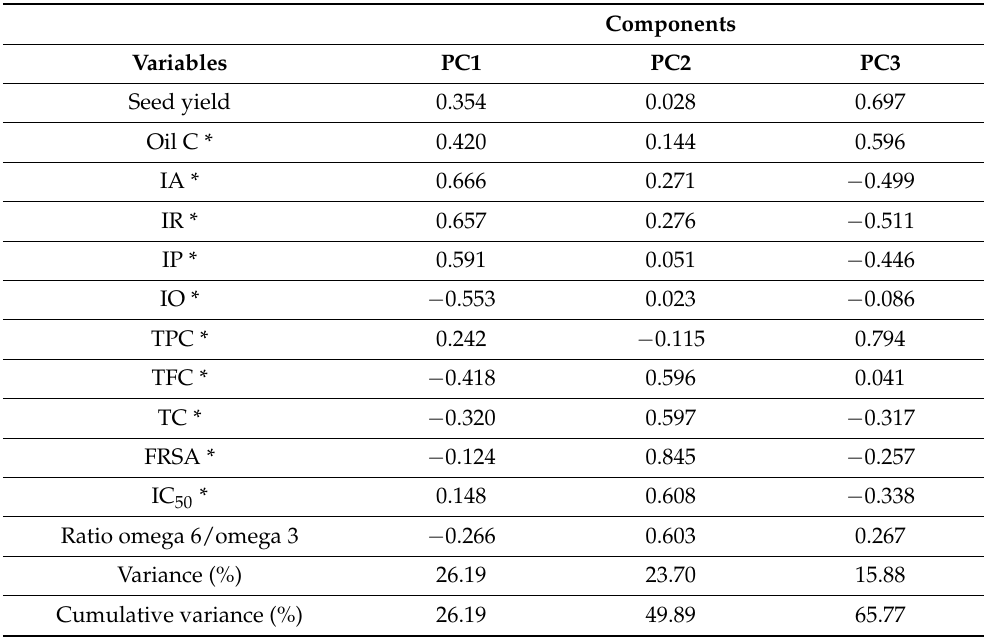
Table 6. Eigenvalues and results of the principal component analysis (for the first three PC) of the quality traits in Moroccan rapeseed